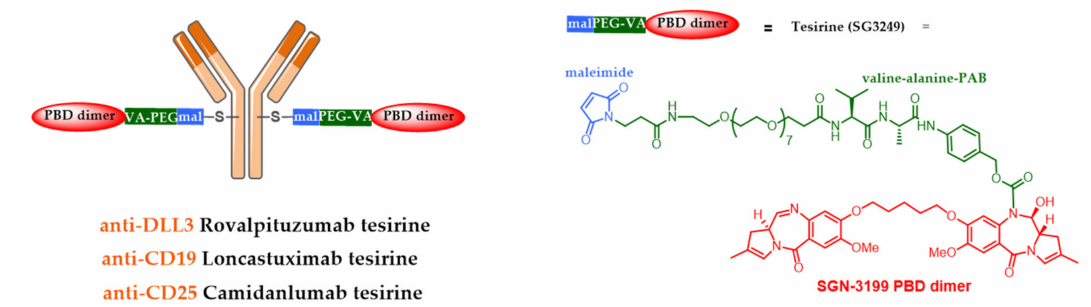
Figure 9. Homogeneous ADCs with a DAR 2 carrying tesirine including a dimeric derivative of PBD